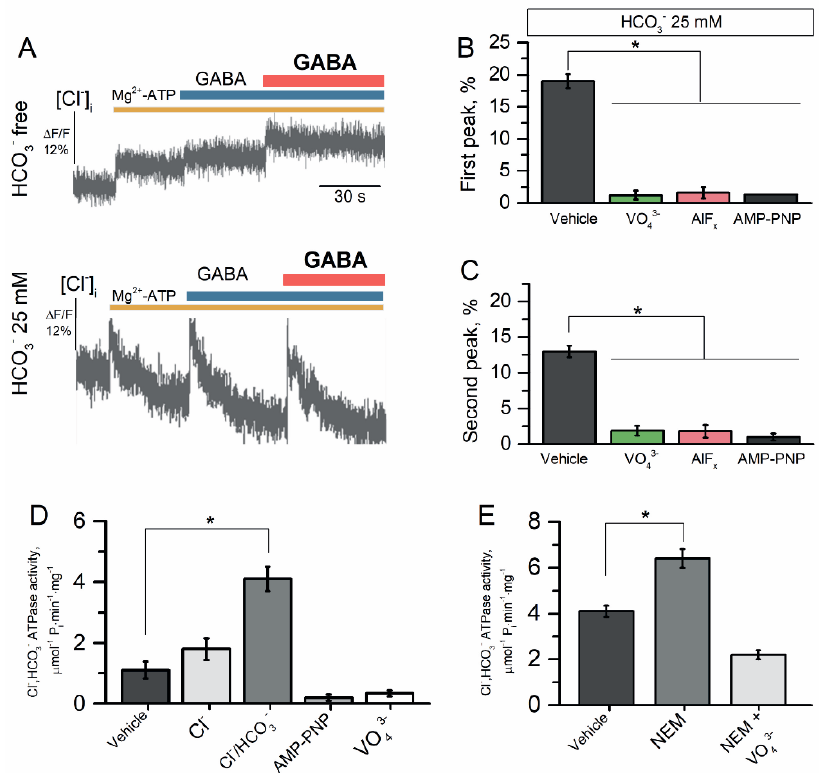
Figure 5. The reconstituted Cl − , HCO 3 − ATPase responsible for GABA A R resensitization. ( A ) Representative images of MQAE fluorescence changes in the proteoliposomes recorded in response to addition of Mg 2+ -ATP (2 mM) before or after first and repeated application of GABA (100 μ M) in an experimental medium in the presence or absence of HCO 3 − (25 mM). ( B ) Bar graph of percentage in MQAE peak fluorescence changes in the proteoliposomes recorded in response to first application of GABA (100 μ M), without or in the presence of VO 43 − (20 μ M), AlF x (20 μ M), or AMP-PNP (2 mM) in an experimental medium (one-way ANOVA, Tukey’s test: F (18,5) = 239.0, р = 0.0000005, n = 4). ( C ) Bar graph of percentage in MQAE peak fluorescence changes in the proteoliposomes recorded in response to first application of GABA (100 μ M), without or in the presence of VO 43 − (20 μ M), AlF x (20 μ M), or AMP-PNP (2 mM) in an experimental medium (one-way ANOVA, Tukey’s test: F (18,5) = 65.0, р = 0.00001, n = 4). ( D ) Bar graph of evaluation of Cl − ATPase or Cl − , HCO 3 − ATPase activity before and after addition of AMP-PNP (2 mM) or VO 43 − (20 μ M) (one-way ANOVA, Tukey’s test: F (9,6) = 7.84, р = 0.005, n = 6). ( E ) Bar graph of evaluation of Cl − , HCO 3 − ATPase activity before and after the application of NEM (300 μ M) without or in the presence of VO 43 − (20 μ M) (one-way ANOVA, Tukey’s test: F (9,6) = 7.84, р = 0.005, n = 6). All data in the bar graphs in this figure and those proceeding it are presented as mean values +/ − SEM; * р < 0.05. The first addition of GABA (100 μ M) to the incubation medium caused a short-term (~1s) efflux of Cl − from the proteoliposomes with a maximal peak of fluorescence change of 18.0 ± 1.3 % ( n = 4) that was quickly restored and reached a plateau during ~60 s of incubation. Repetitive application of GABA (100 μ M) also caused a short-term (~1s) efflux of Cl − from the proteoliposomes with a maximal peak of fluorescence change of 13.0 ± 0.5 % ( n = 4) that was quickly restored and reached a plateau during ~60s. Both the first and repetitive application of the agonist were inhibited by γ PAs, showing the involvement of ATPase activity (Figure 5B,C). To examine the role of ATPase in the GABA-mediated Cl − influx into proteoliposomes, we studied its activity in the absence or presence of γ PAs. The